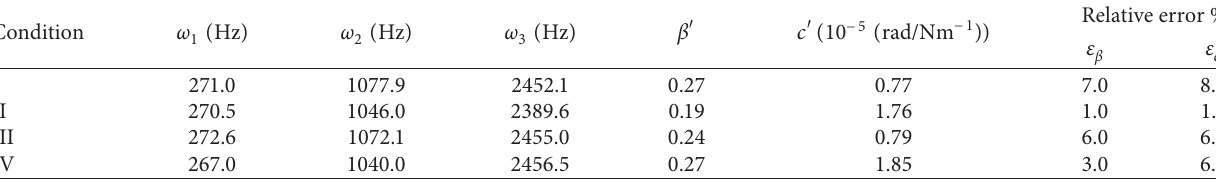
Table 2: Measurement results of the local flexibility of crack.